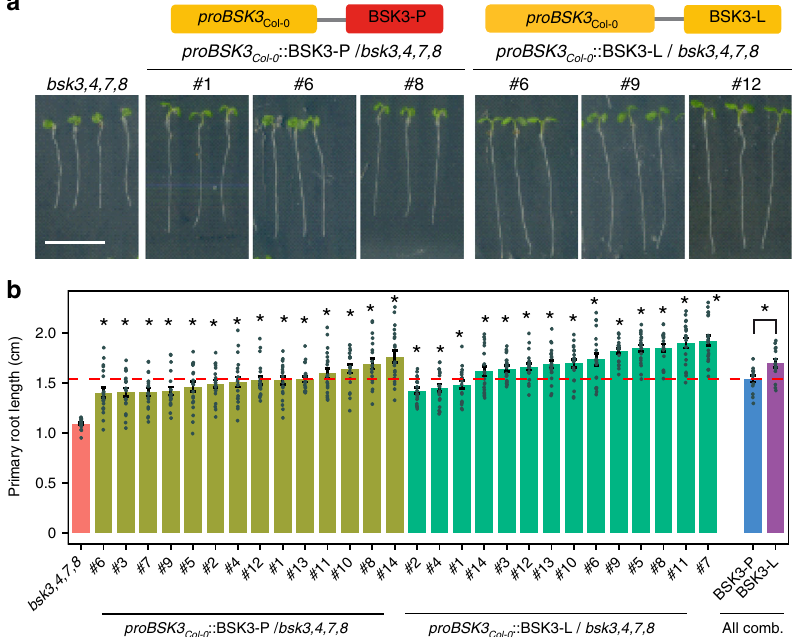
Fig. 3 Allelic variation of BSK3 determines root length. a Schematic of transgenic constructs used for complementation of the bsk3 , 4 , 7 , 8 quadruple mutant and representative photographs of 6-day-old plants. Three representative lines for each construct are shown. Scale bar, 1 cm. b Primary root length of bsk3 , 4 , 7 , 8 and 14 independent T2 lines for each construct. Bars represent means ± SEM ( n = 20 independent biological replicates). Average values of 14 independent lines for each construct are also shown (all comb.). Asterisks indicate statistically signi fi cant differences between complementation lines and bsk3 , 4 , 7 , 8 mutant or between two BSK3 protein variants according to Welch ’ s t -test (* P <